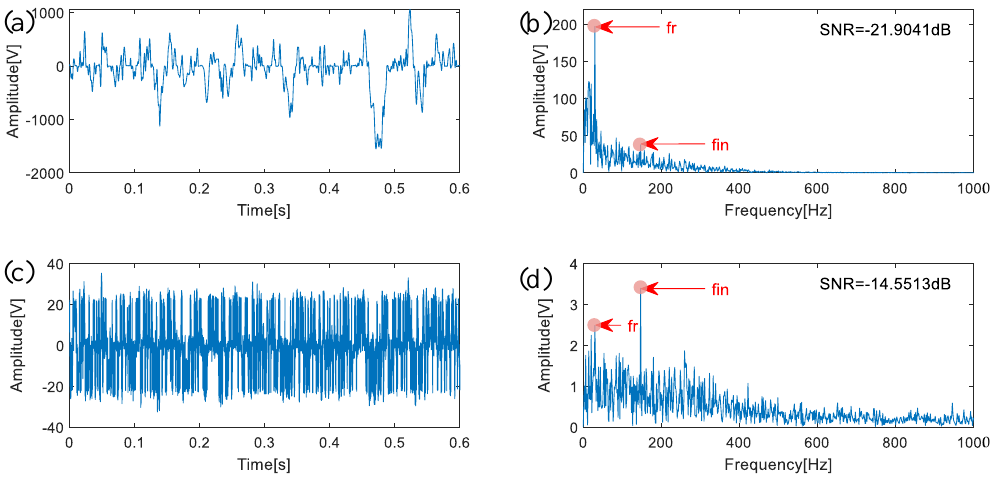
Figure 12. Waveform and spectra of inner ring signals processed by MCCK-based USR method and CSK-based APHSR method.